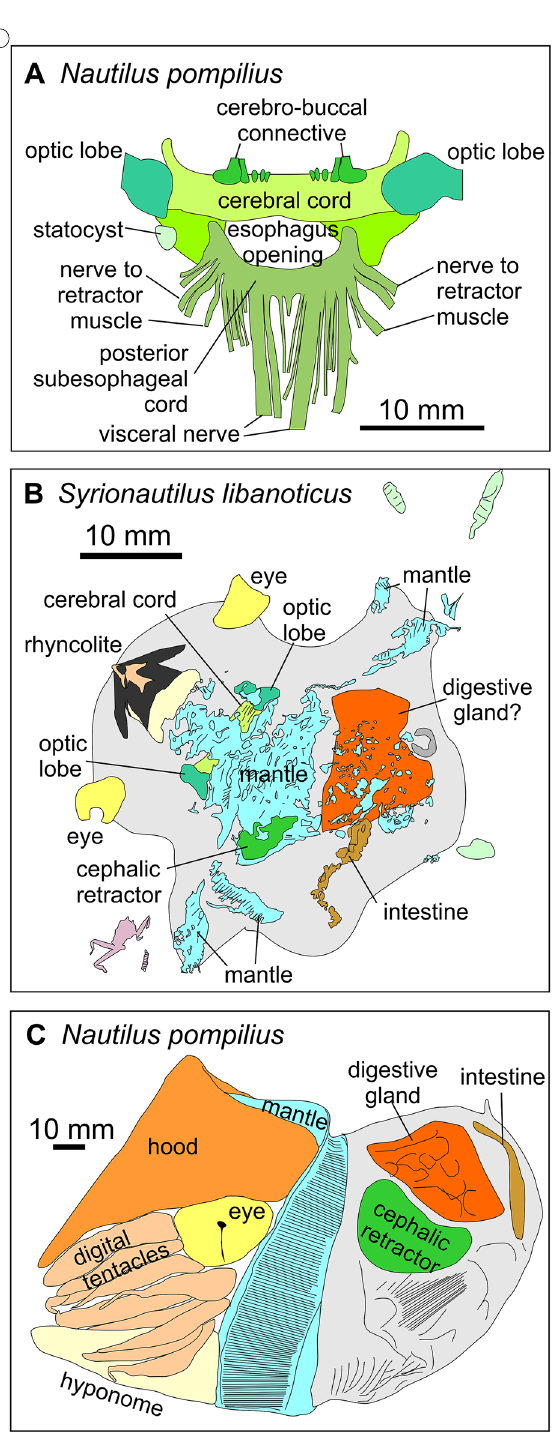
Fig. 3 Homologisation of the structures seen in the isolated soft parts of Syrionautilus libanoticus with those in Nautilus pompilius indicated by the same colours for supposedly homologous structures. A Central nervous system of N. pompilius drawn after Fig. 14A in Sasaki et al. (2010). B Isolated soft parts of S. libanoticus from Fig. 1D with different colours. C Lateral view of the isolated soft parts of N. pompilius drawn after Fig. 1A in Sasaki et al.